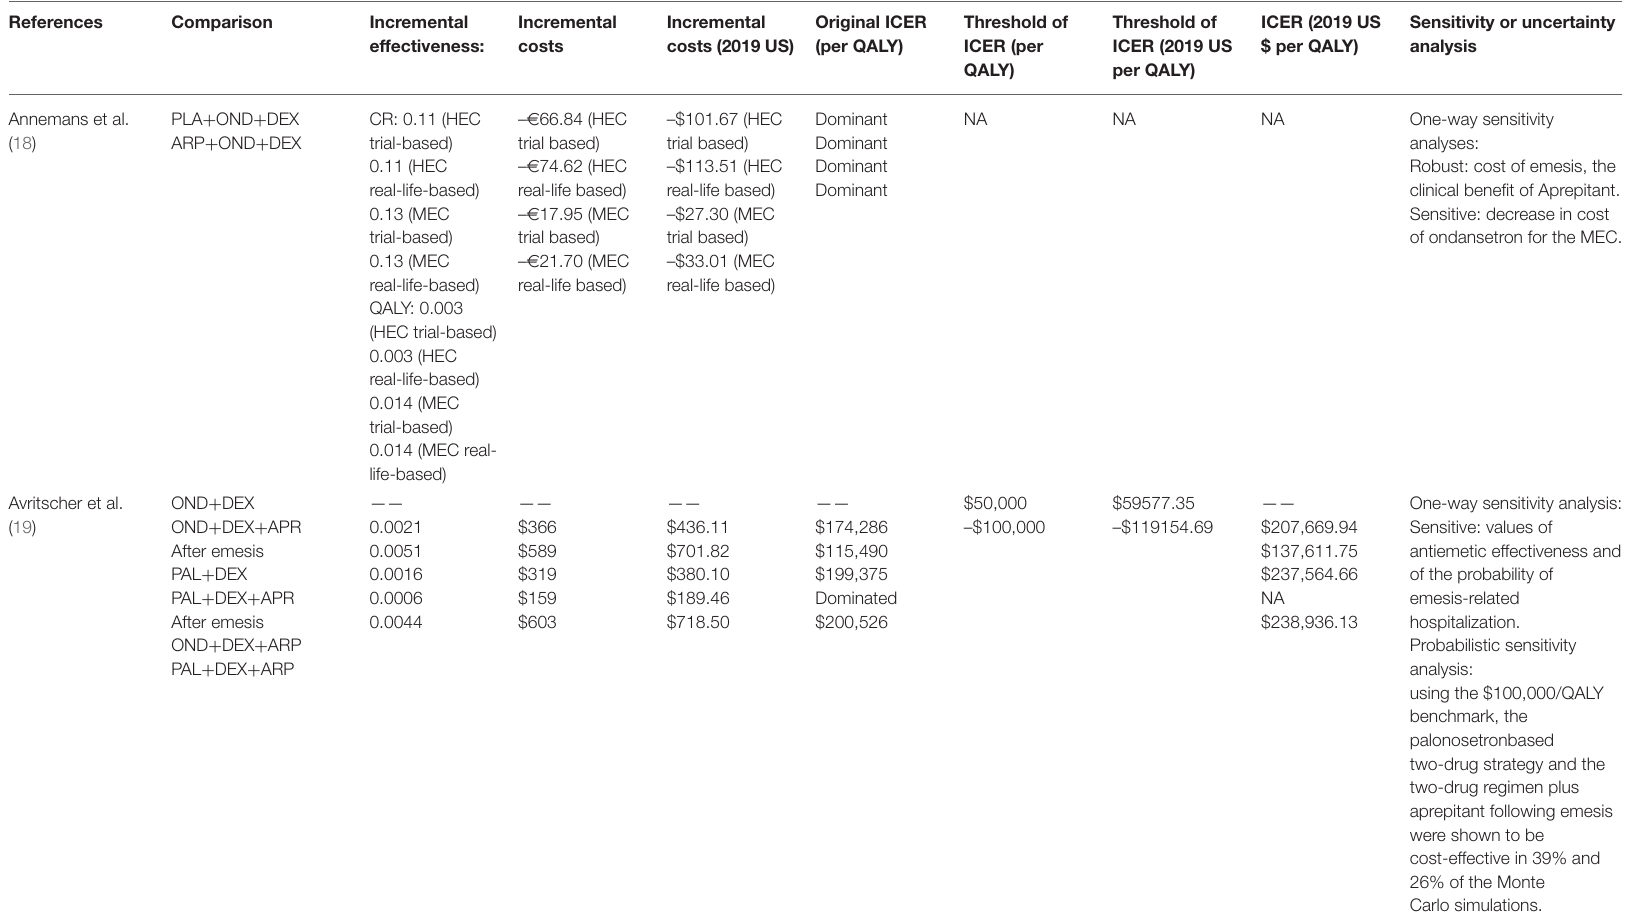
TABLE 4 | Summary of economic evaluation outcomes comparing aprepitant regimen (aprepitant, 5-HT3RA and dexamethasone) vs. standard regimen (5-HT3RA and